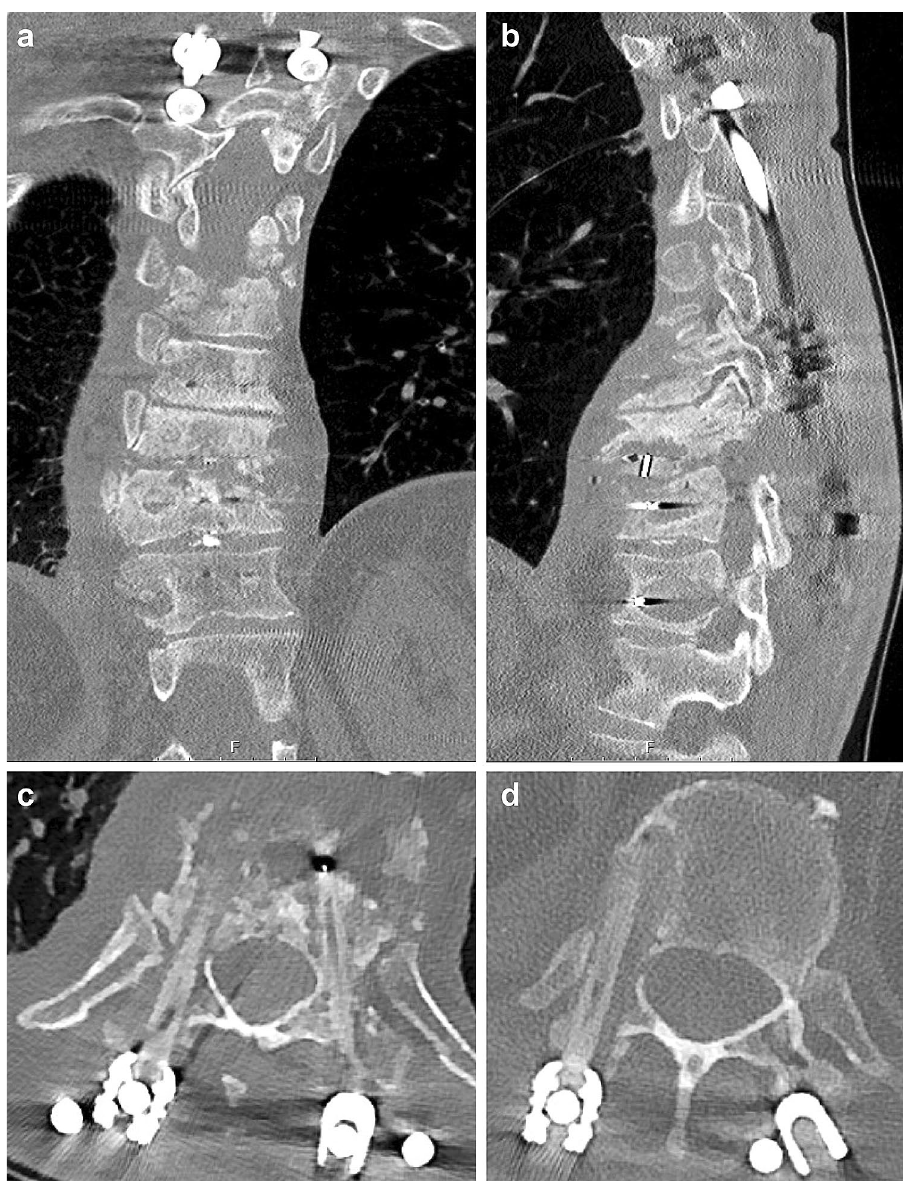
Figure 3. Example 2 of CT-imaging of screw loosening after CFR-PEEK instrumentation. CT-scan of a case of screw loosening after CFR-PEEK instrumentation T5–6–9–10–11–12 involving the affected vertebra on level T11. There a halo signs around the screws of T11 and 12 on the right side as a sign for loosening. ( a ) coronal plane; ( b ) sagittal plane, ( c , d ) axial plane of T11 and T12.